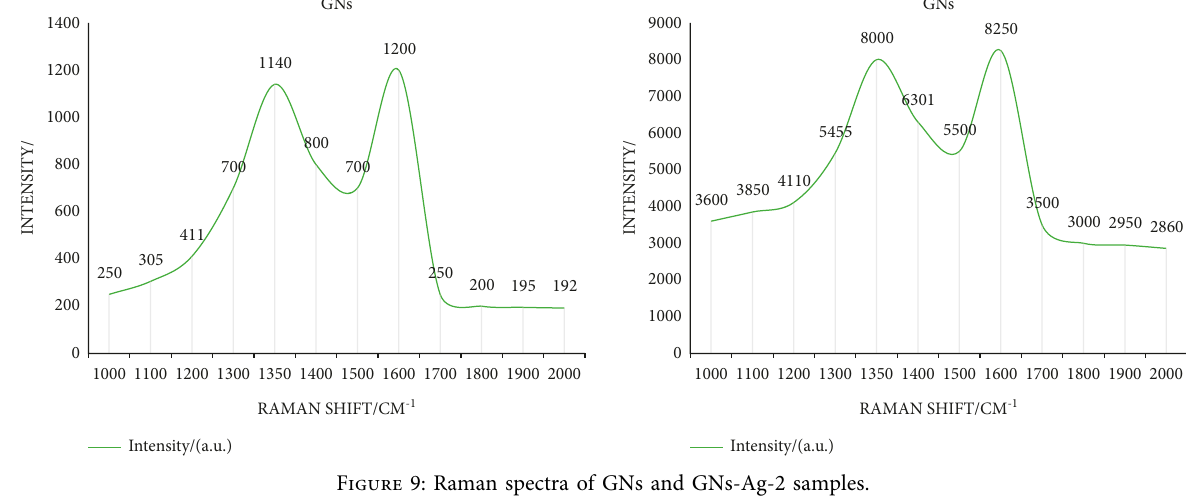
Figure 9: Raman spectra of GNs and GNs-Ag-2 samples.